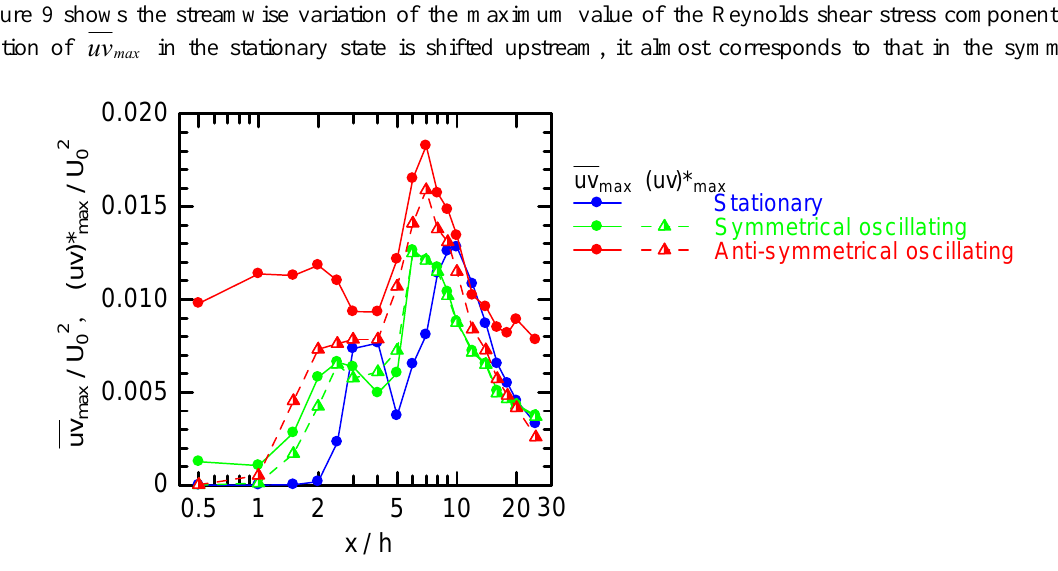
Fig. 9 Streamwise variation of Reynolds shear stress